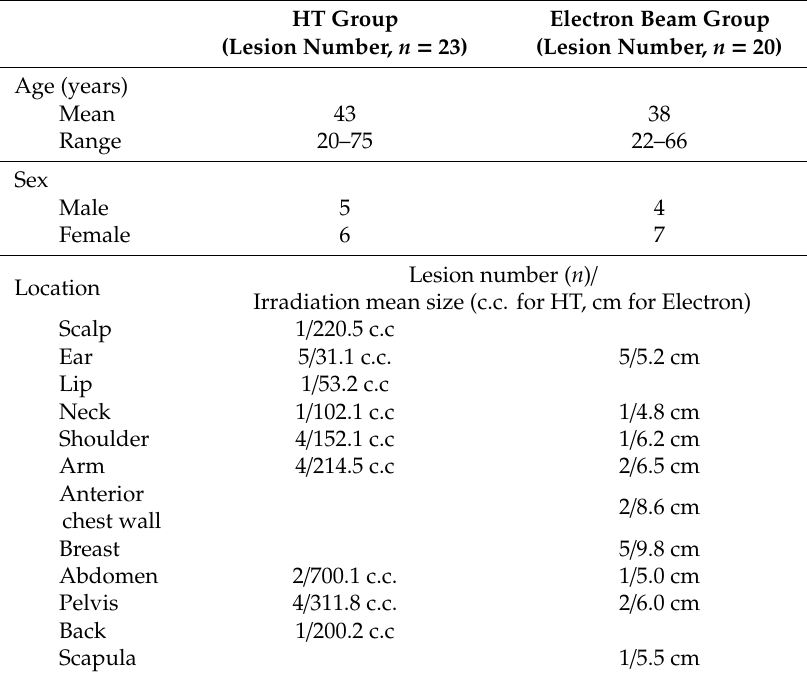
Table 1. Patient characteristics.